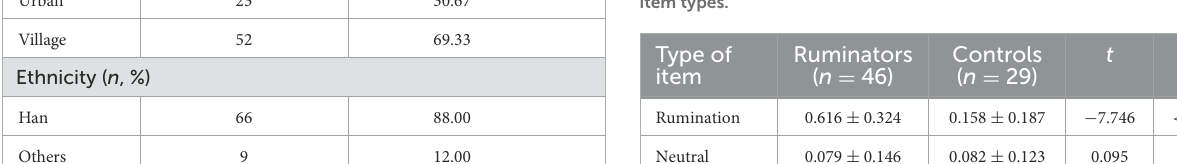
TABLE 7 Arousal rates ( ¯ x ± SD) of the ruminators and controls on both item